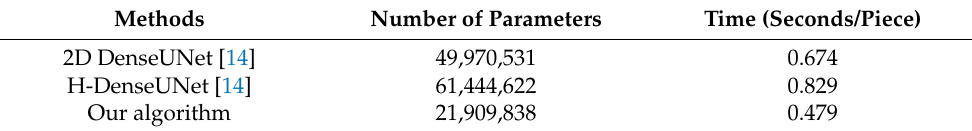
Table 5. Comparison of the parameter quantity and calculation efficiency of the network